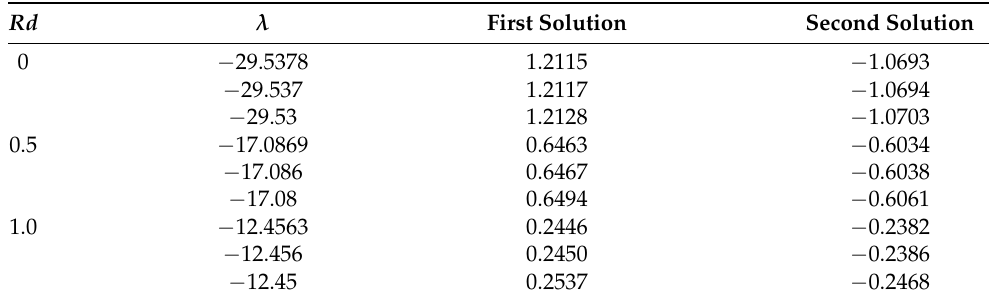
Table 7. Minimum eigenvalues ζ for some values of Rd and λ when S = 1.0, ϕ 1 = ϕ 2 = 0.02 and Pr =